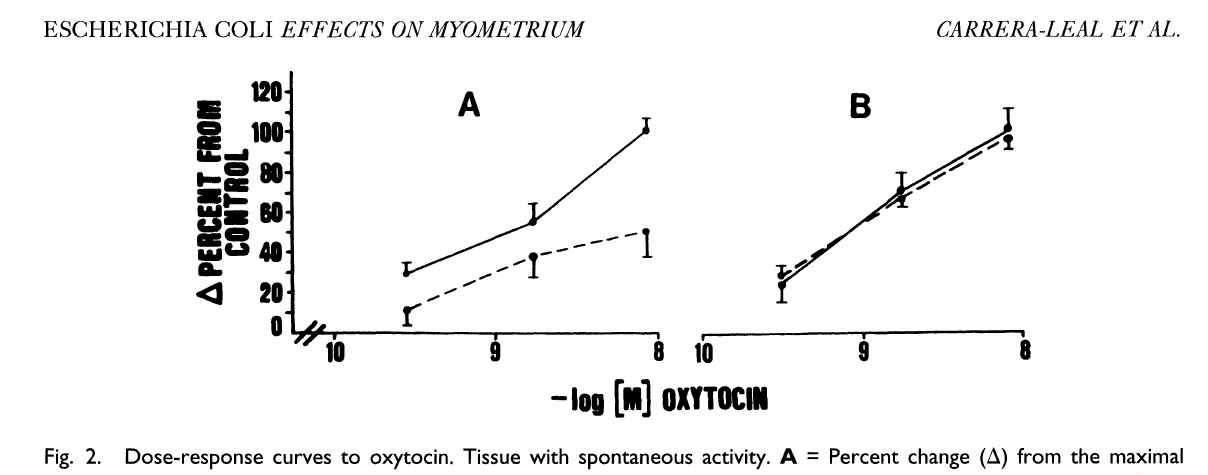
Fig. 2. Dose-response curves to oxytocin. Tissue with spontaneous activity. A Percent change (A) from the maximal contraction produced by oxytocin before (solid line) and in the presence of vehicle (broken line). B Before (solid line) and in the presence of toxin (broken line) (X +